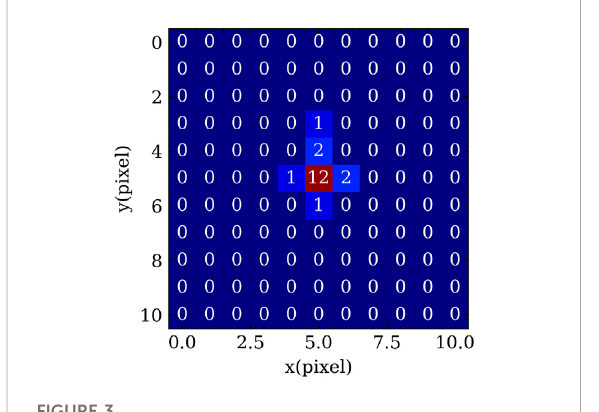
FIGURE 3 The spot image displayed in a matrix way.